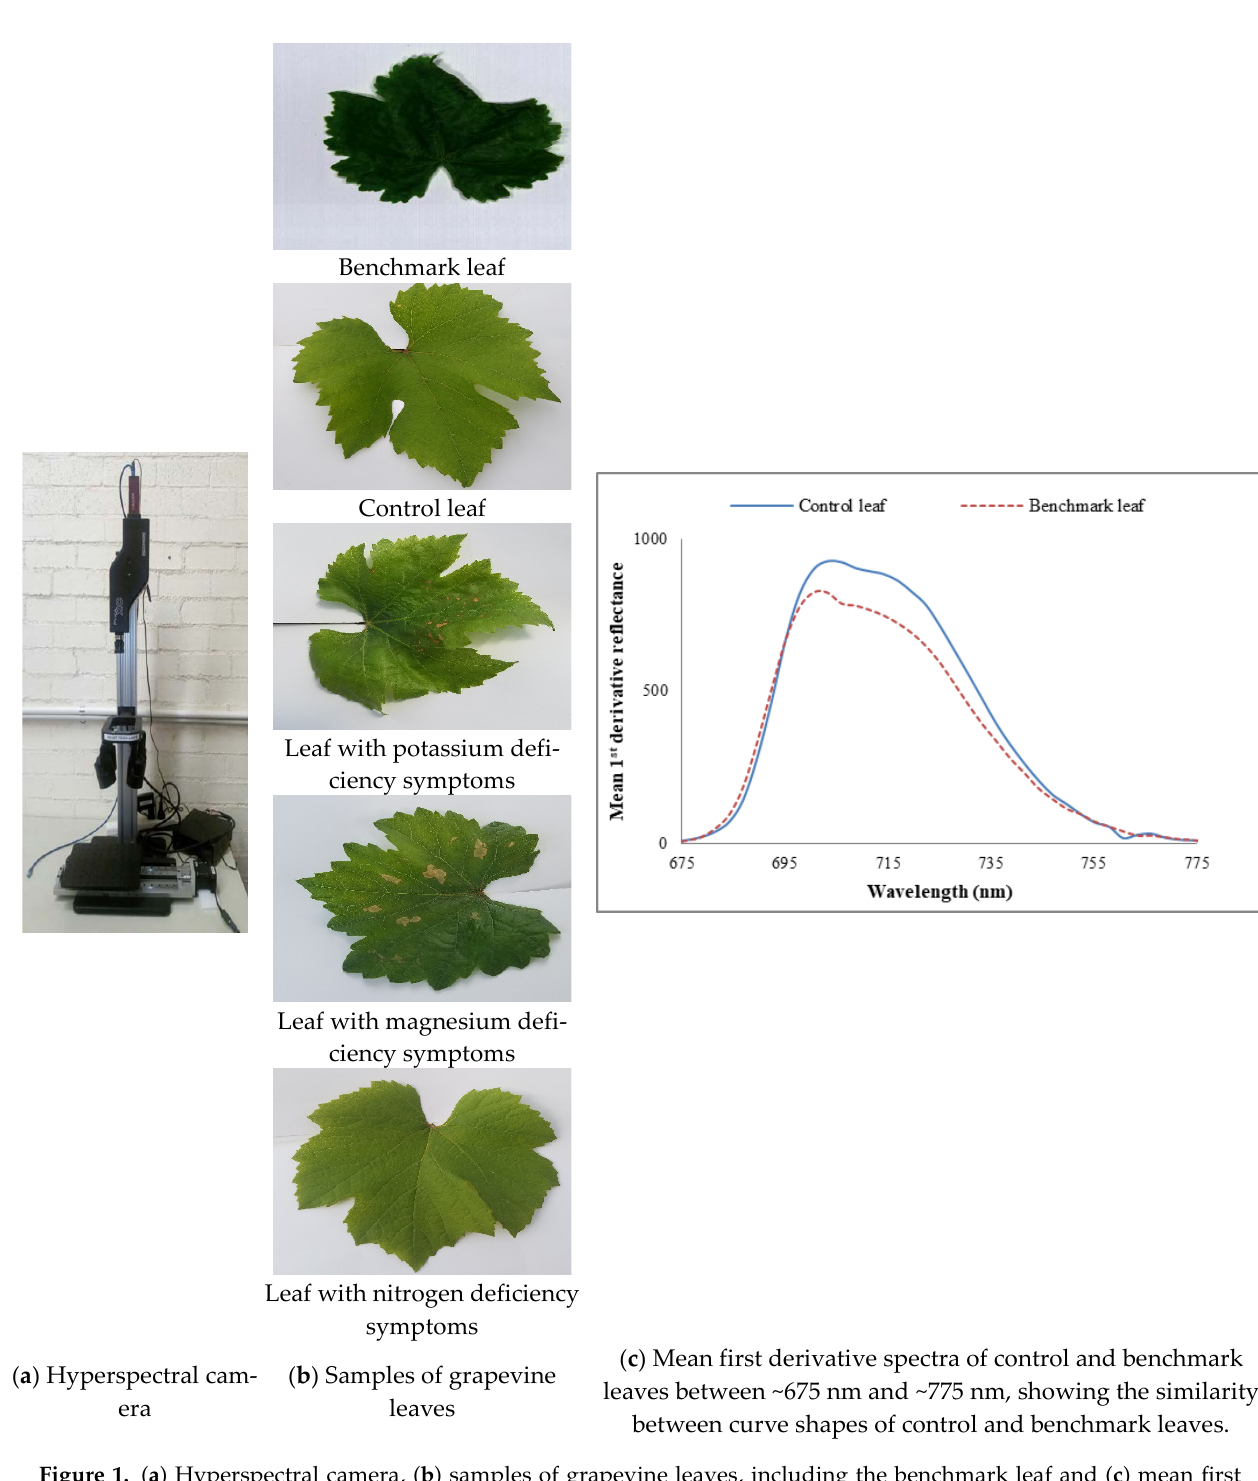
Figure 1. ( a ) Hyperspectral camera, ( b ) samples of grapevine leaves, including the benchmark leaf and ( c ) mean first derivative spectra of control and benchmark leaves between ~675 nm and ~775 nm, showing the similarity between curve shapes of control and benchmark leaves.